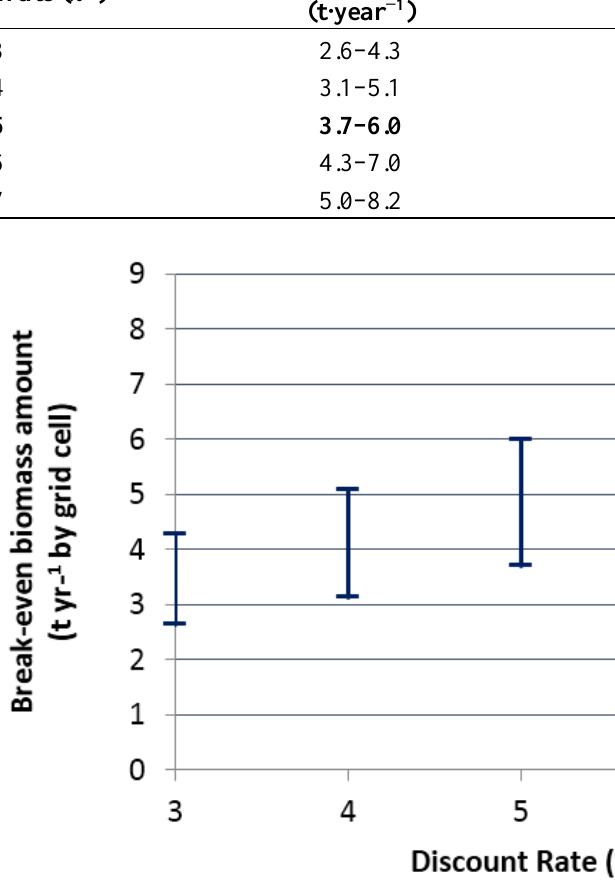
Figure 3. Ranges of break-even biomass amount at different discount